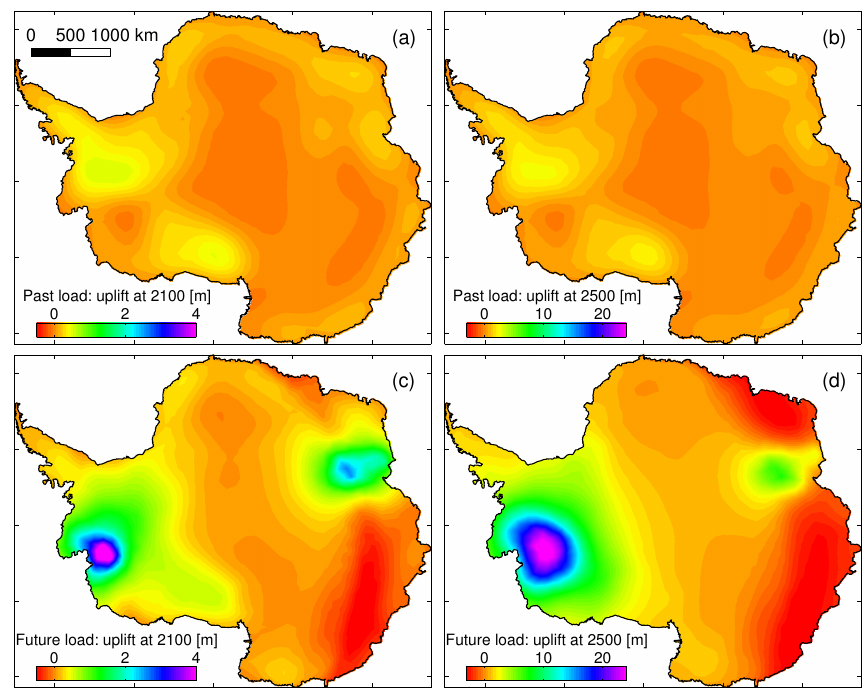
Figure 4. Role of past and future ice loading in the future bed topography. GIA uplift at (a) AD 2100 and (b) AD 2500 obtained by forcing the calibrated ISSM/GIA model (cf. Fig. 2.) by the past loading alone. Future DIHs are assumed to be zero. Corresponding solutions (model- average) at (c) AD 2100 and (d) AD 2500 associated with future ice loading alone. Past DIHs are assumed to be zero. For ease of comparison, we use the same color scale for each year. (Results in Figs. 4a and b are in the respective ranges of [− 0 . 1 , 0 . 5 ] and [− 0 . 5 , 2 . 5 ] m.) Also, see Supplement Fig. S7 where we replot some of these figures with a different color scale that better illustrates the spatial